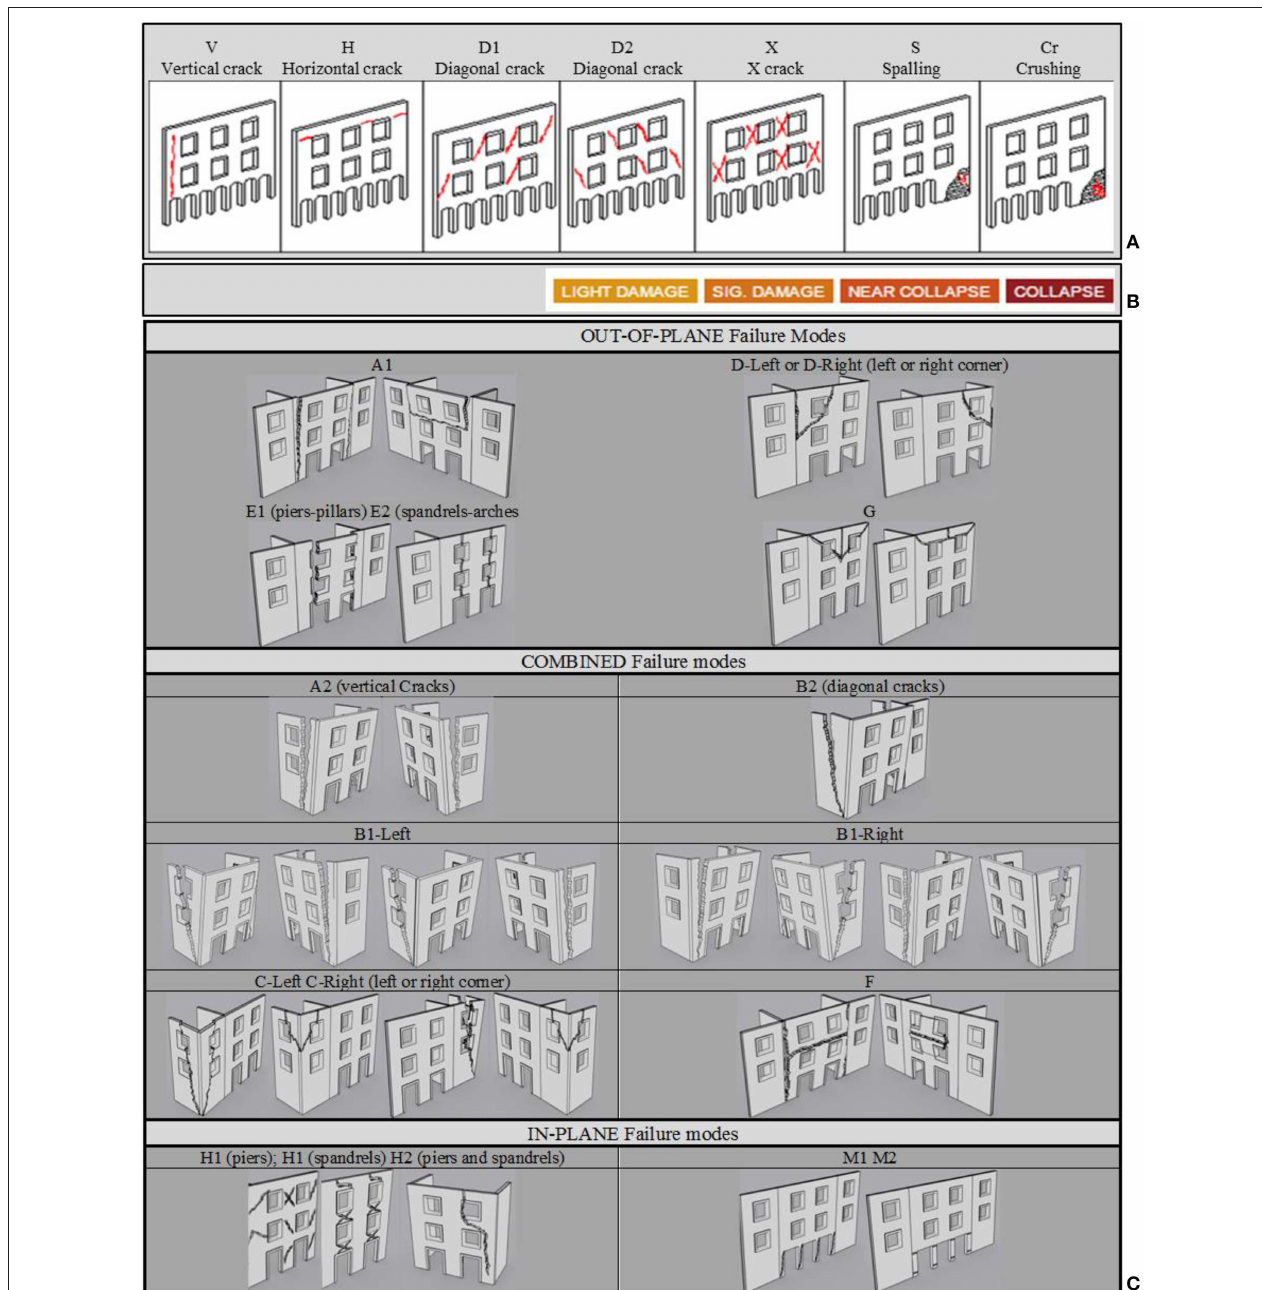
FIGURE 7 | Taxonomy adopted to classify (A) crack types; (B) crack severities; and (C) failure